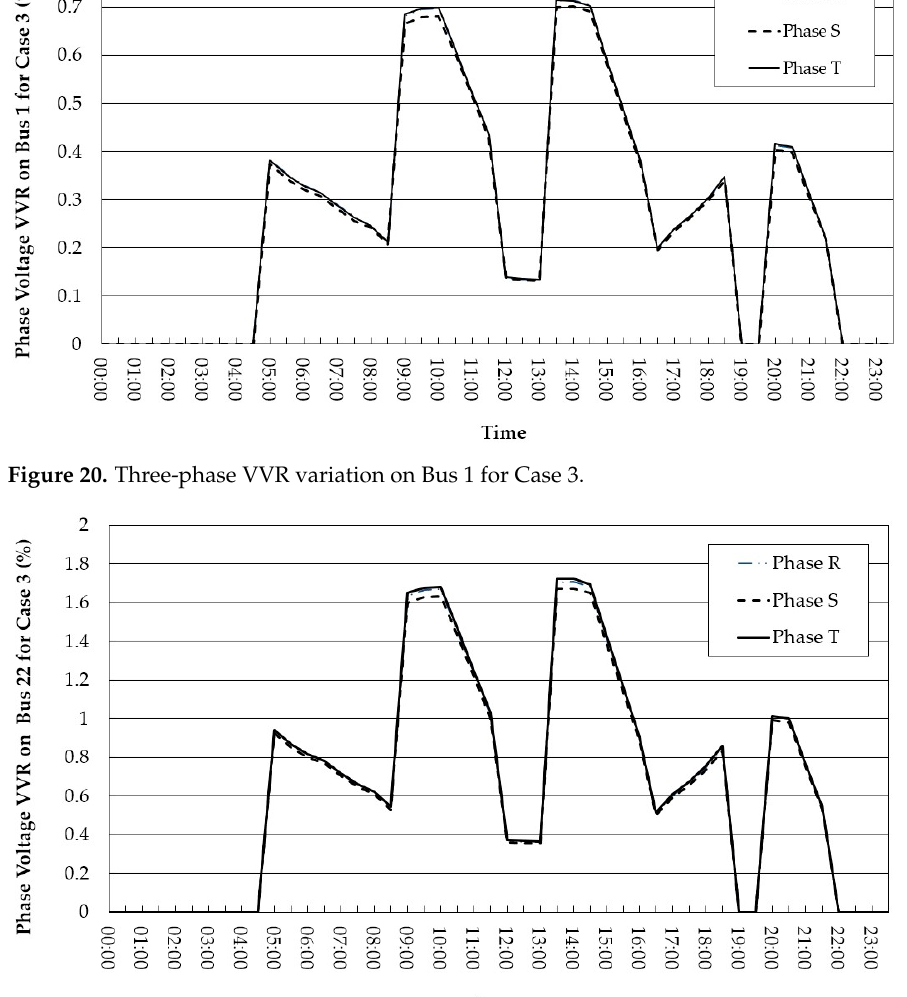
Figure 21. Three-phase VVR variation on Bus 22 for Case 3.